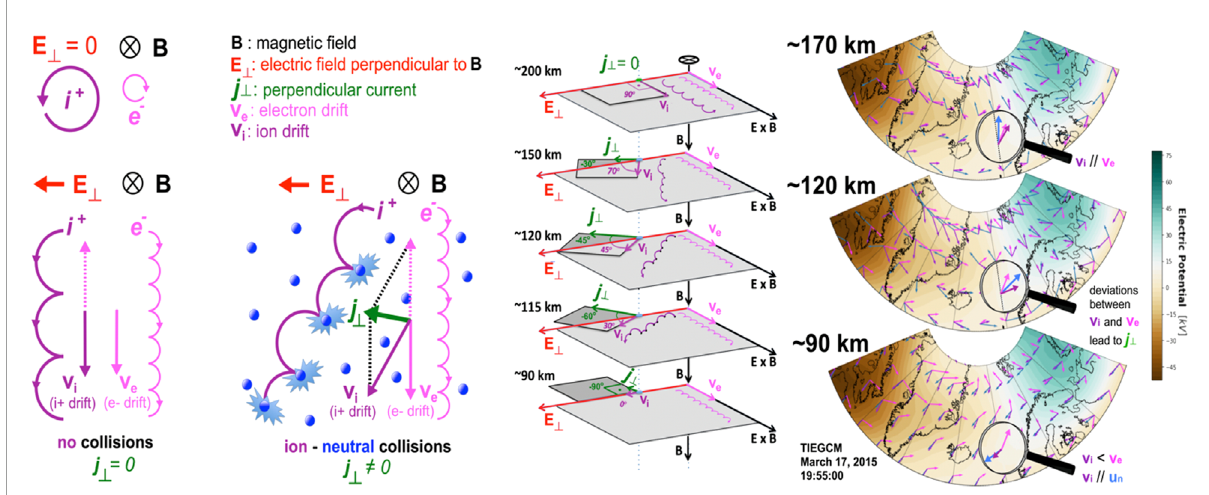
FIGURE 2 Ion and electron (E × B) drifts in the frame of the neutral gas as a function of altitude (i.e. neutral density and collision frequency), and resulting electric